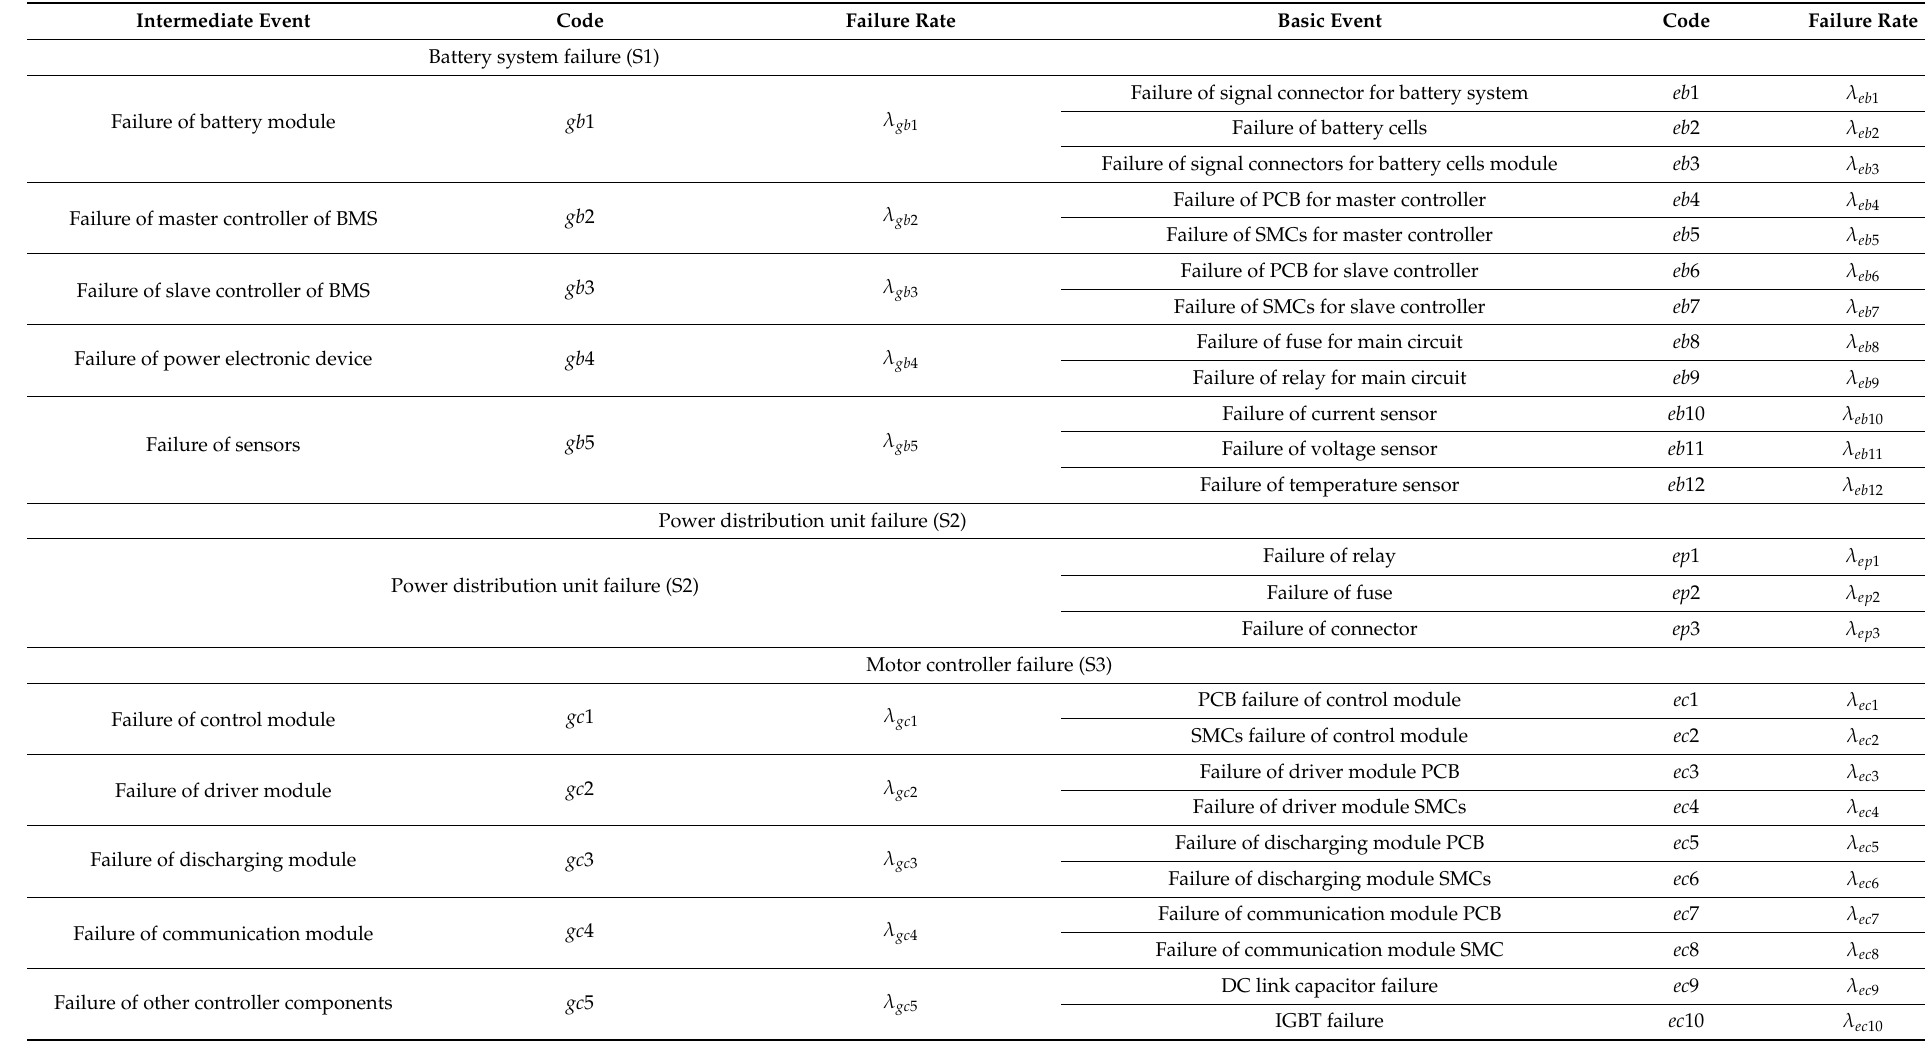
Table 1. Failure events of powertrain